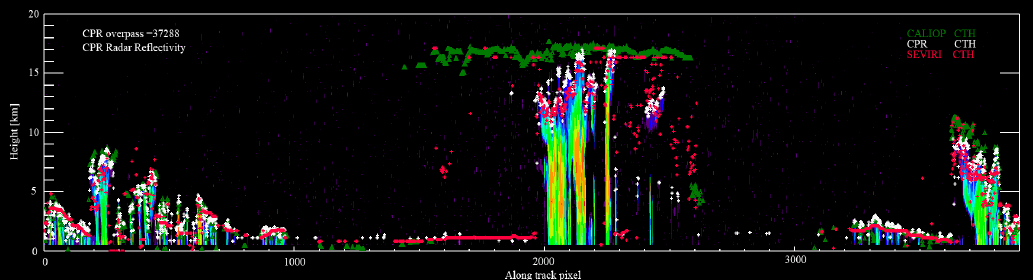
Figure 3. Colour-coded Cloud Profiling Radar (CPR)-derived radar reflectivity and cloud-top heights (CTHs) along CPR overpass 37,288 on 1 May 2013. CTHs from Cloud-Aerosol LiDAR with Orthogonal Polarization (CALIOP), CPR, and Spinning Enhanced Visible and Infrared Imager (SEVIRI) are plotted as dark green triangles and white and red crosses, respectively.